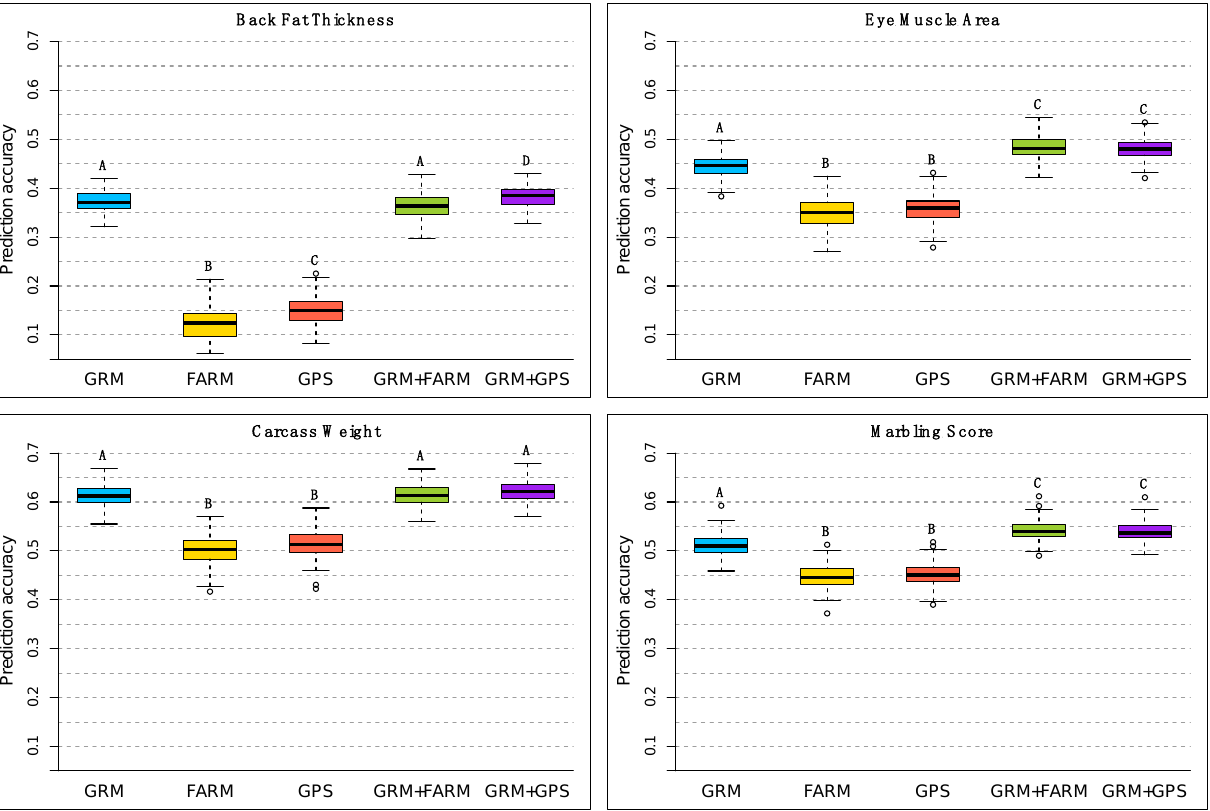
Figure 4. Accuracy of phenotypic prediction ( 𝑟 𝑦 = 𝑐𝑜𝑟(𝒚̃ 𝑡𝑒𝑠𝑡 , 𝒚 𝑡𝑒𝑠𝑡 ) ), for all four traits and all the five models considered. Boxplots based on 100 cross validation replicates of each model. The predicted phenotypes were 𝒚̃ 𝑡𝑒𝑠𝑡 = 𝑿 𝑡𝑒𝑠𝑡 𝒃̂ + 𝒈̃ 𝑡𝑒𝑠𝑡 for the GRM model, 𝒚̃ 𝑡𝑒𝑠𝑡 = 𝑿 𝑡𝑒𝑠𝑡 𝒃̂ + 𝜼̃ 𝑡𝑒𝑠𝑡 for the FARM and the GPS models, and 𝒚̃ 𝑡𝑒𝑠𝑡 = 𝑿 𝑡𝑒𝑠𝑡 𝒃̂ + 𝒈̃ 𝑡𝑒𝑠𝑡 + 𝜼̃ 𝑡𝑒𝑠𝑡 for the GRM + FARM and GRM + GPS models. Letters A, B, C, D indicate the groups obtained with Tukey’s multiple comparison test at a significance level of 0.05, comparing the values of 𝑟 𝑦 obtained with the different models, within each trait. Figure 5 presents the comparison of the variance structures between 𝑮 and 𝑾 = 𝒁𝒁′ , and between 𝑮 and 𝑾 = 𝒁𝑬𝒁′ , using the kappa statistics [35]. We 𝜂 𝐹𝐴𝑅𝑀 𝜂 𝐺𝑃𝑆 observed that 𝜿 𝜂:𝐺𝑅𝑀 and 𝝀 𝜂 are not aligned at all, and that 𝜿 𝜂:𝐺𝑅𝑀 ≈ 1 , indicating that there is no confounding between the two relationship matrices.